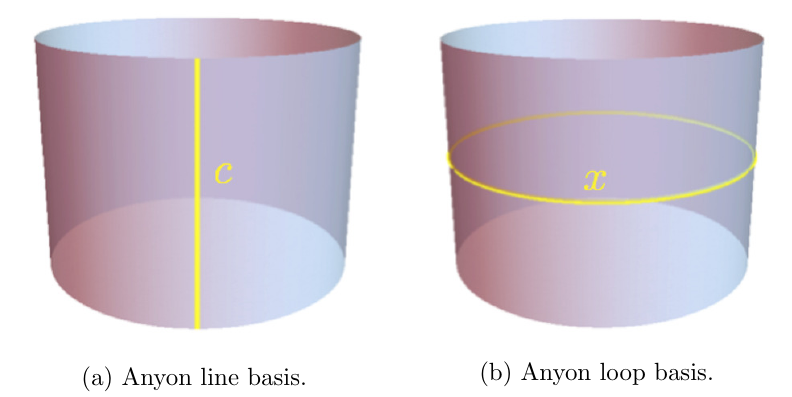
Figure 2. For a cylinder topology with non-trivial GSD, the ground states can be speci(cid:12)ed either by anyon line connecting the upper and lower physical boundary, or by anyon loop winding around non-contractible cycle.